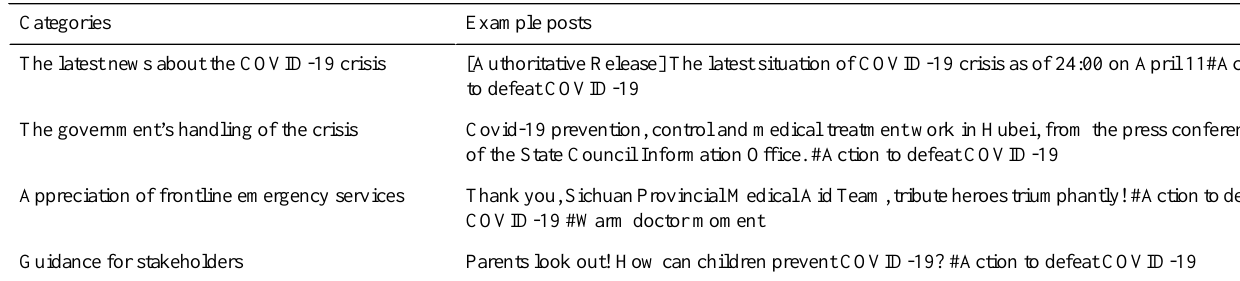
Table 1. Codebook examples of content categories.